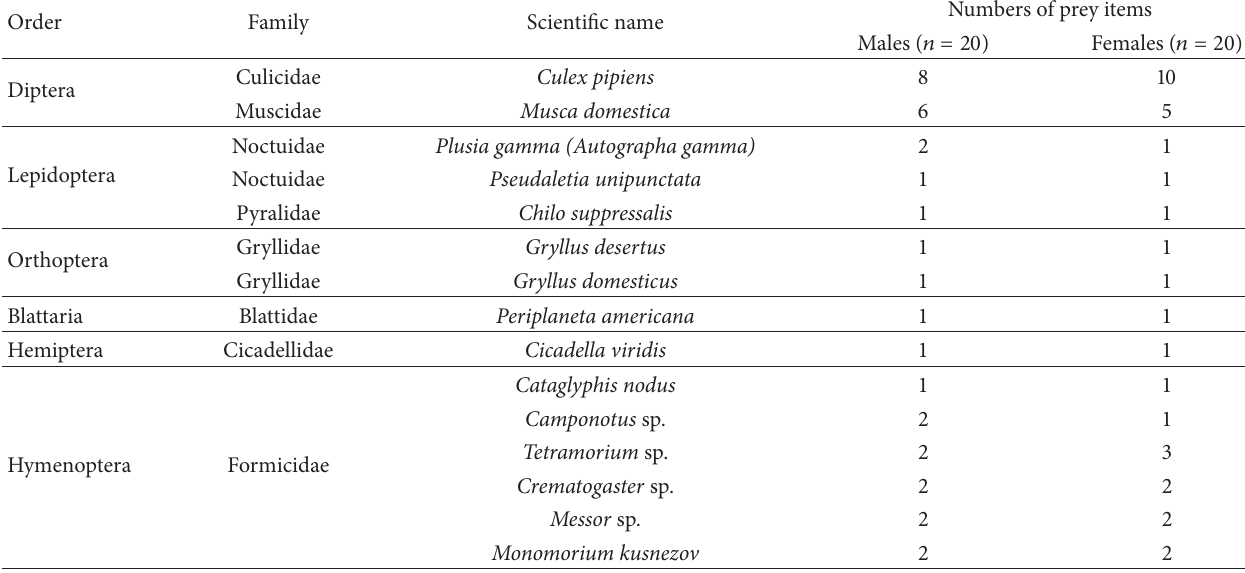
Table 2: The number of prey items identified in the stomachs of males and females of T . caspius. Order